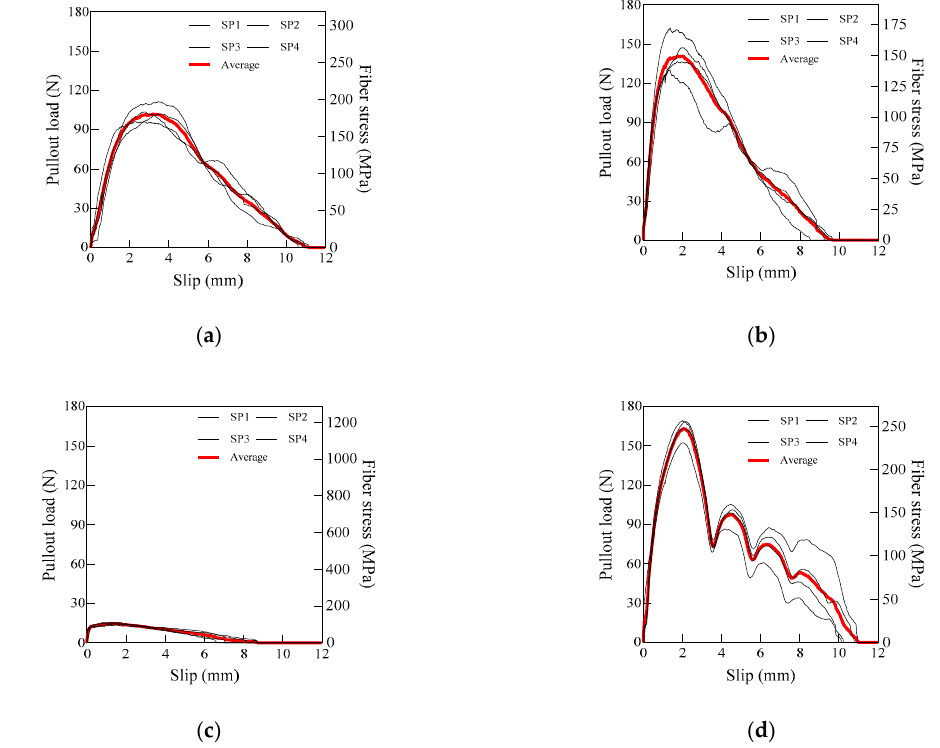
Figure 5. Pullout load versus slip curves of WFN and CP fibers: ( a ) WFN2; ( b ) WFN3; ( c ) CP1; ( d ) CP2.